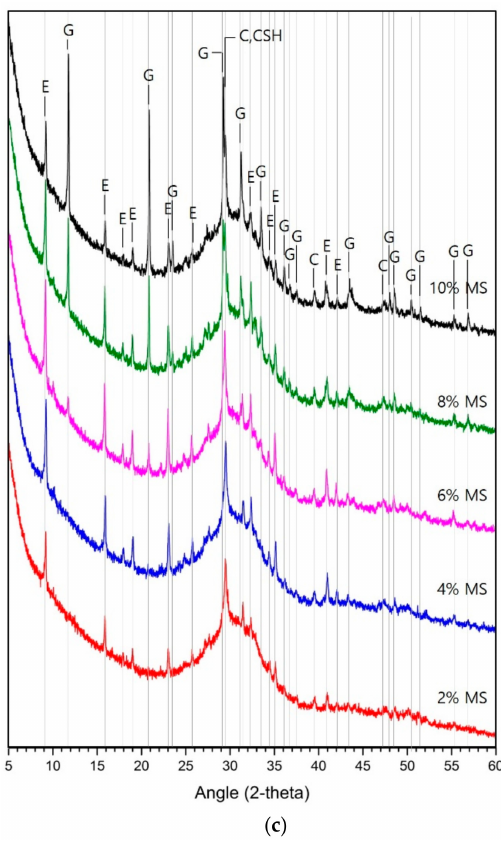
Figure 2. XRD analysis: ( a ) 3 days, ( b ) 7 days, ( c ) 28 days, E: Ettringite, G: Gypsum, C: Calcite, CSH: C-S-H gel, M: Magnesium oxide.